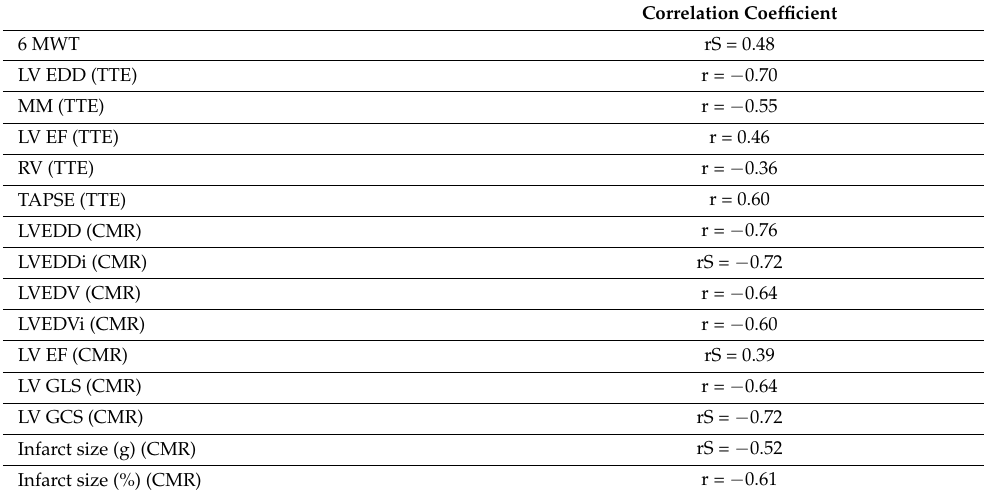
Table 4. Correlation of different clinical and imaging parameters with the reversibility score (CMR 4 score vs. PET 3/2/1/0